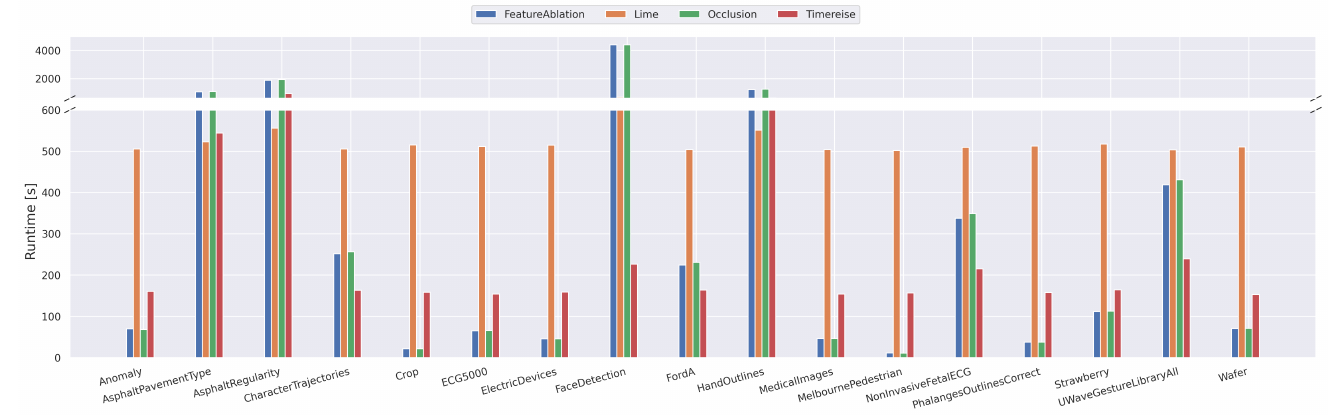
Figure 5. Runtime Real Data. Shows the runtime on the real datasets used in all experiments below. The runtime is given in seconds for 100 attribution maps. TimeREISE shows a stable runtime across all datasets. For long-sequence datasets the runtime of the other approaches increases.